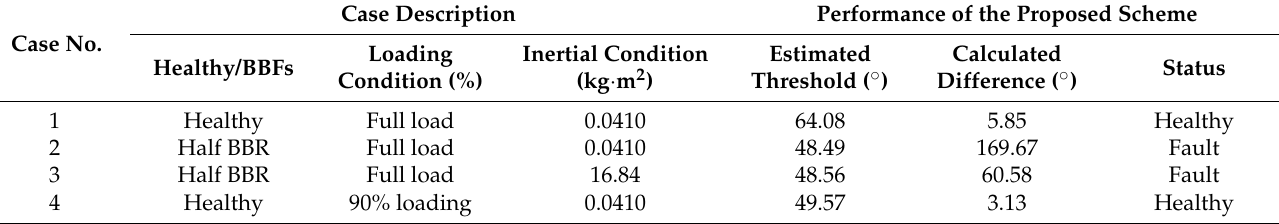
Table 3. Testing the proposed scheme on Motor